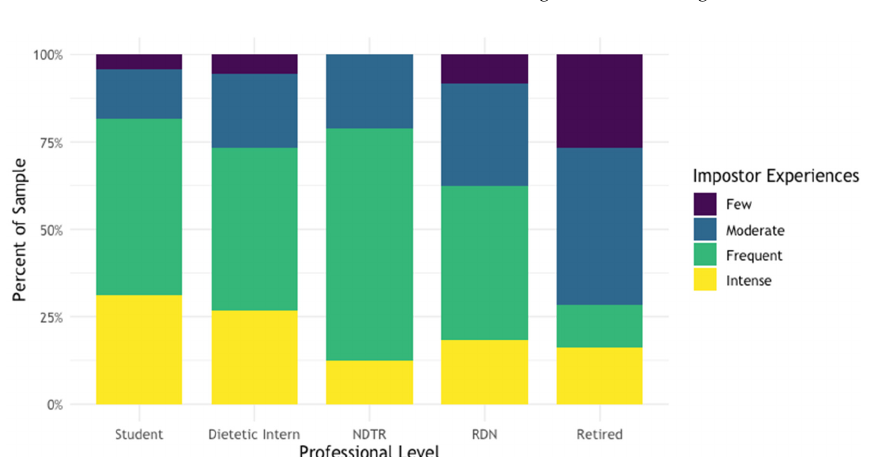
Abbreviations: NDTR, Nutrition and Dietetics Technician Registered; RDN, Registered Dietitian Nutritionist.